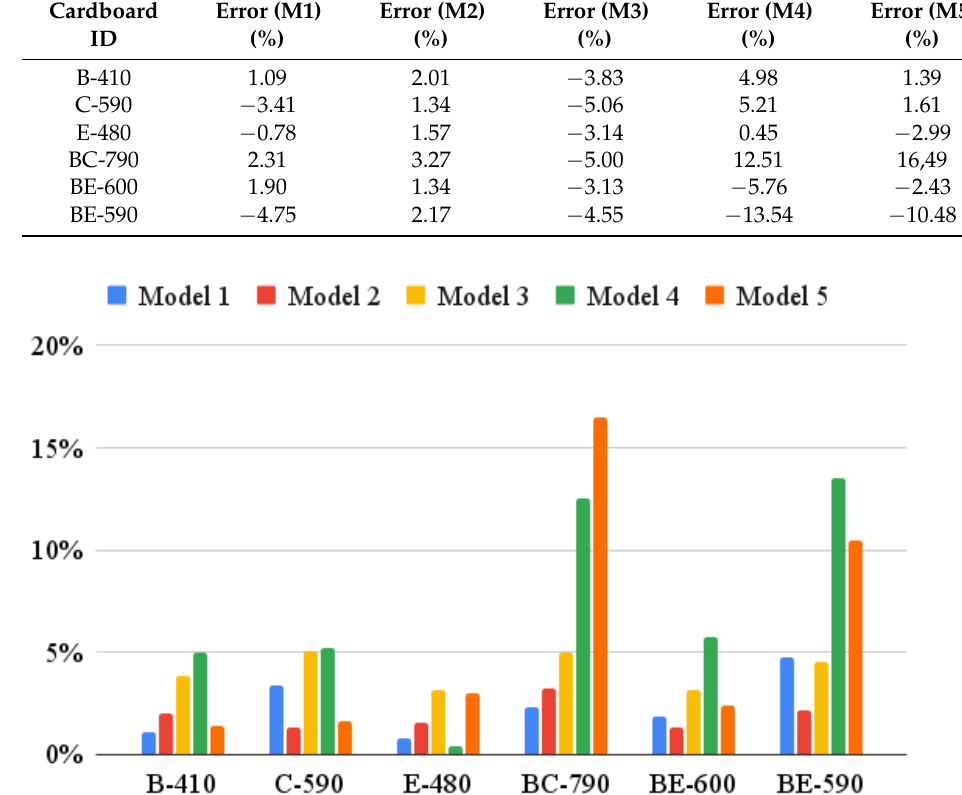
Table 7. Estimation error obtained using five different models.